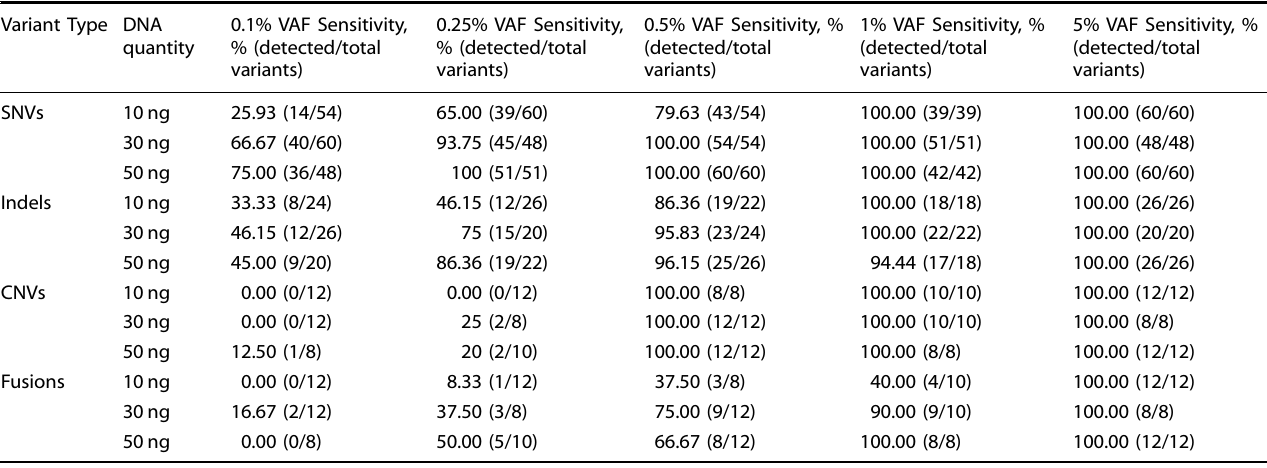
Table 1. xF sensitivity.